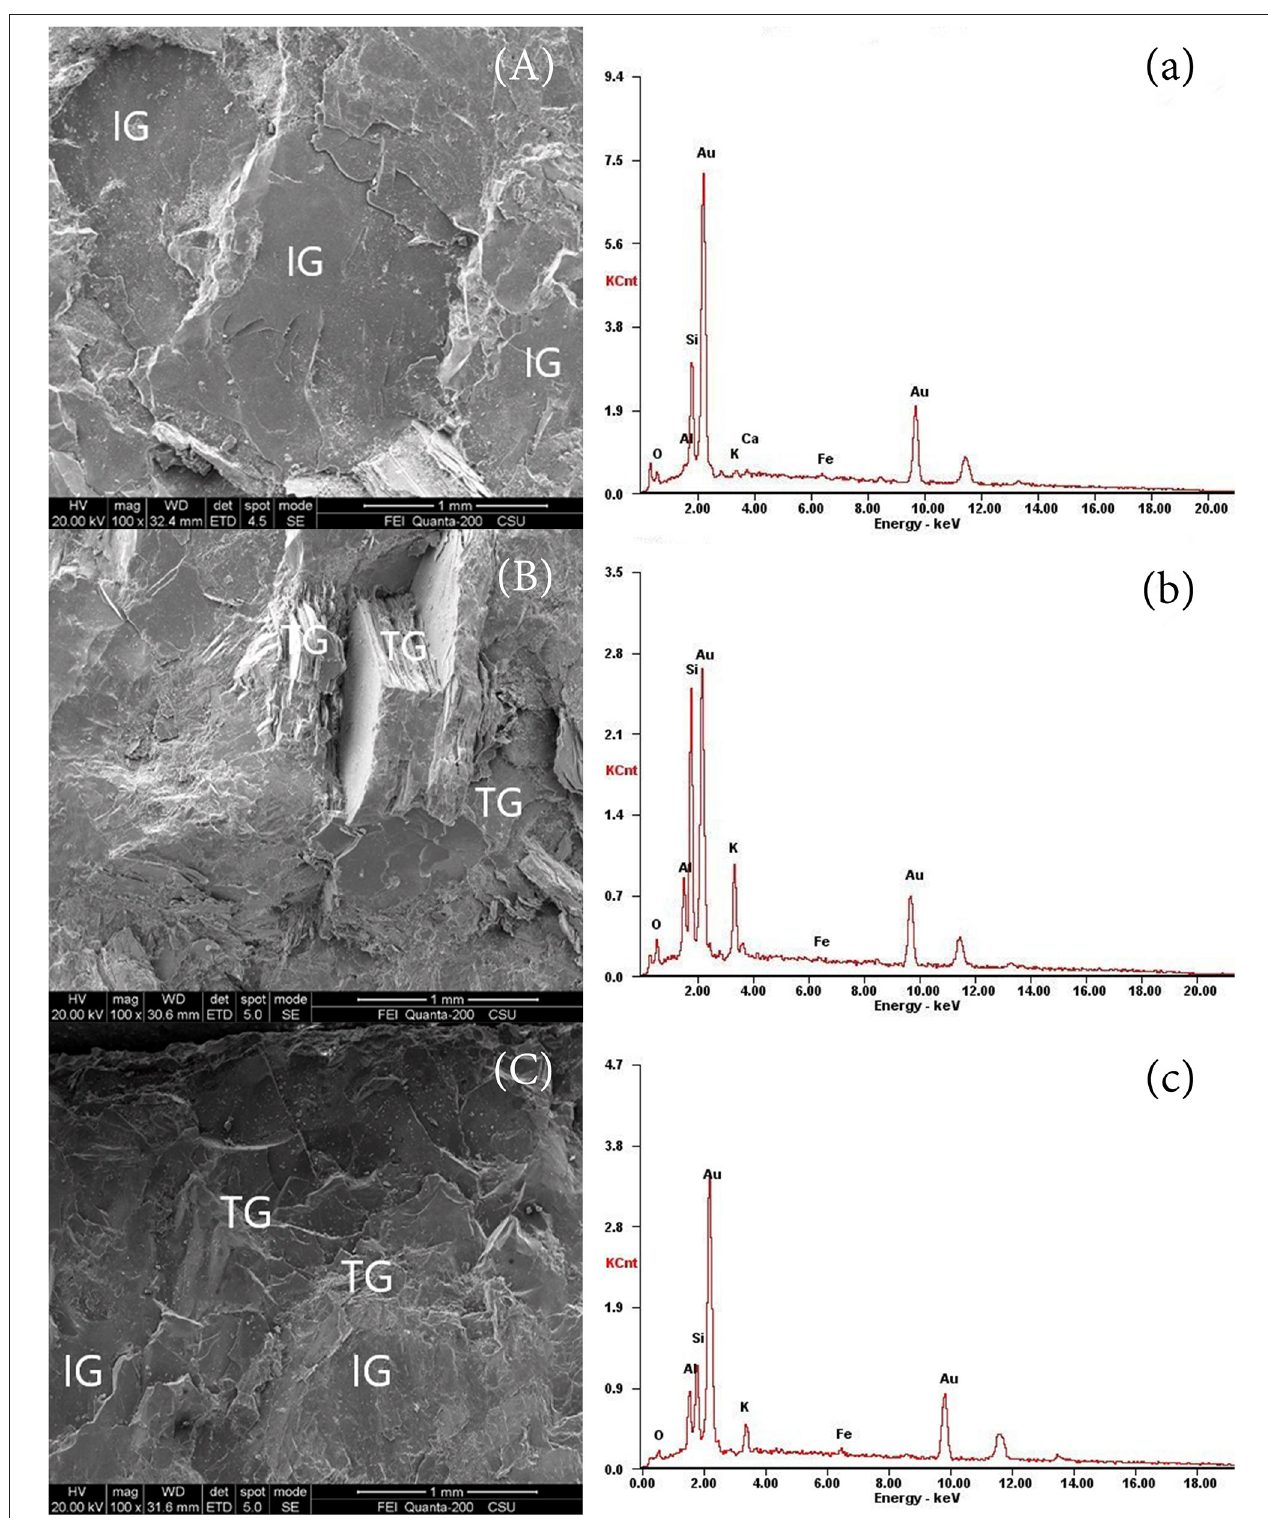
FIGURE 5 | Scanning electron miscroscope (SEM) photos of the fracture surfaces for granite under the Brazilian split test (A) , most of fracture surfaces have clear inter-granular cracks and shows “smooth planar” morphology of quartz, (a) energy spectrogram corresponding with (A) . (B) This is a typical transgranular crack surface and shows “sidestep” morphology of k-feldspar, (b) energy spectrogram corresponding with (B) . (C) There are intergranular and transgranular cracks and shows “stack-up” morphology of k-feldspar, (c) energy spectrogram corresponding with (C) .